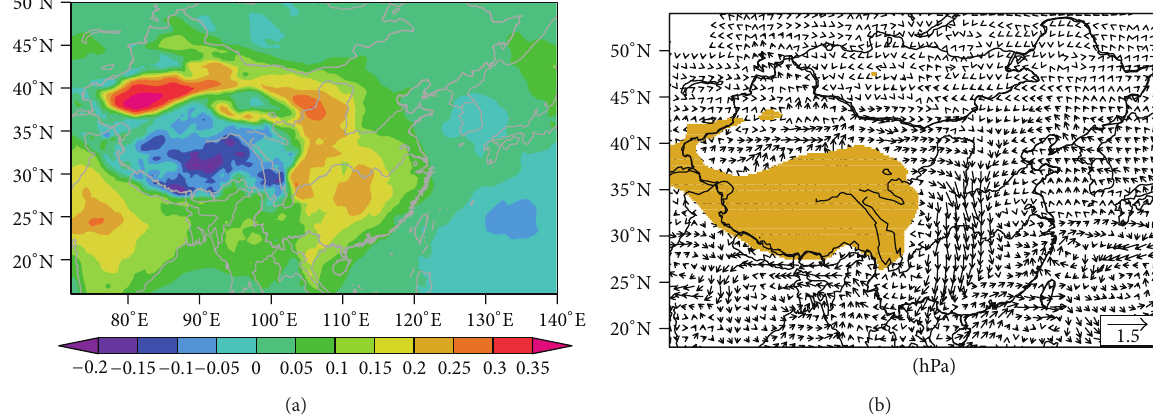
Figure 8: The simulated (a) SLP and (b) 850 hPa wind differences in ms −1 between Dust and Nodust experiments averaged in winter during 2000–2009